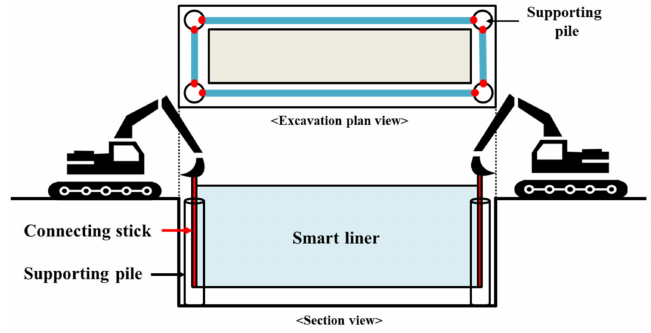
Figure 4. Schematic diagram of RSIM.